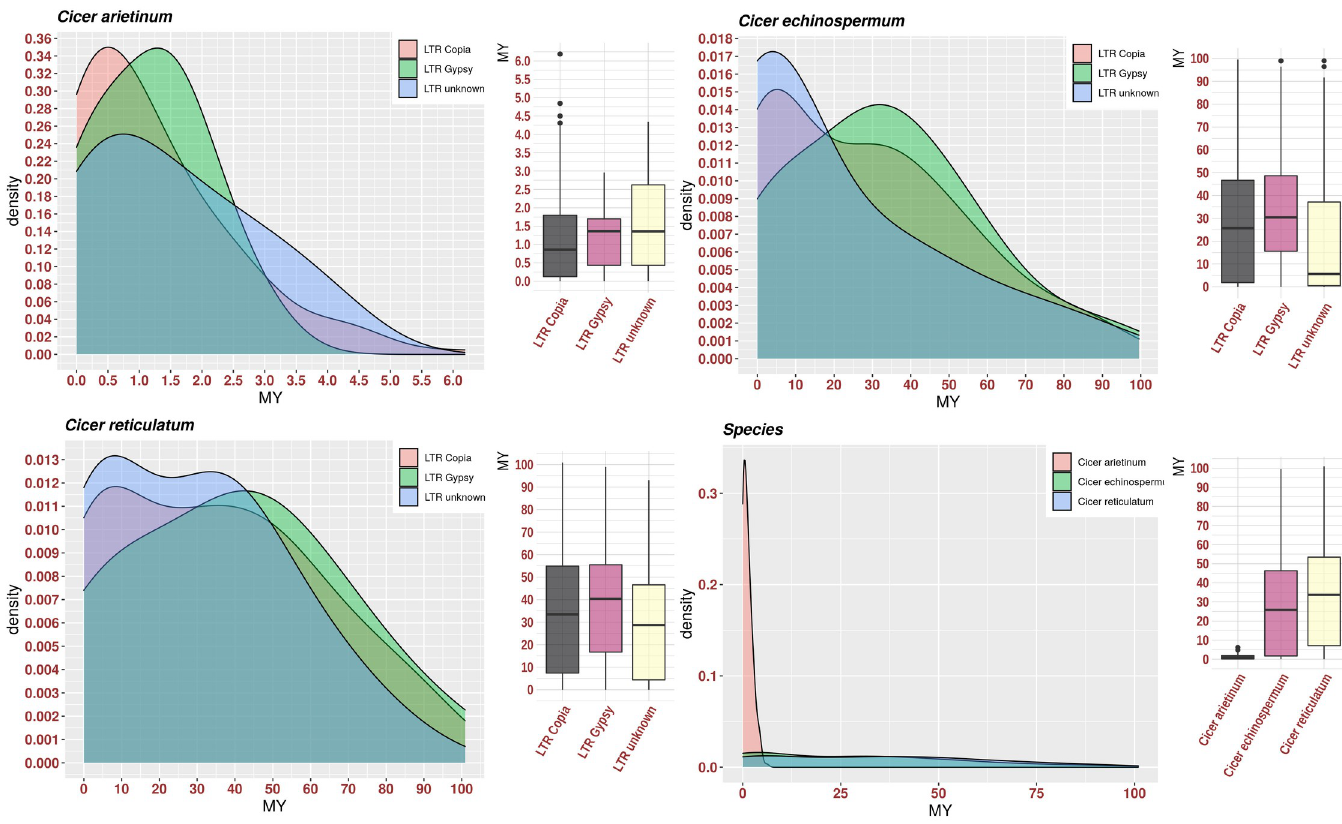
Fig 3. Estimation of Cicer species LTR-RT insertion age in millions of years